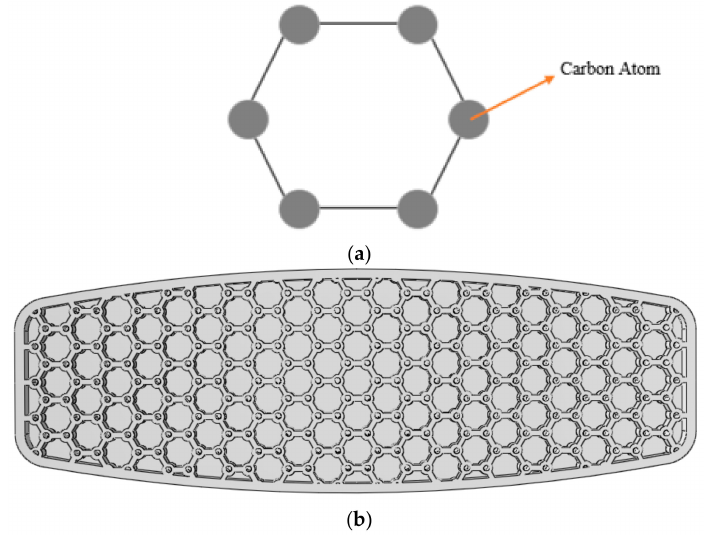
Figure 17. ( a ) Carbon atoms placed in the six edges of a hexagon; ( b ) Bottom shell with the carbon atom configuration structure.